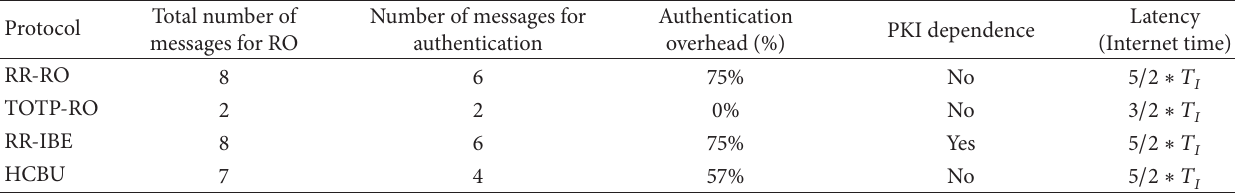
Table 3: Comparison of Route Optimization